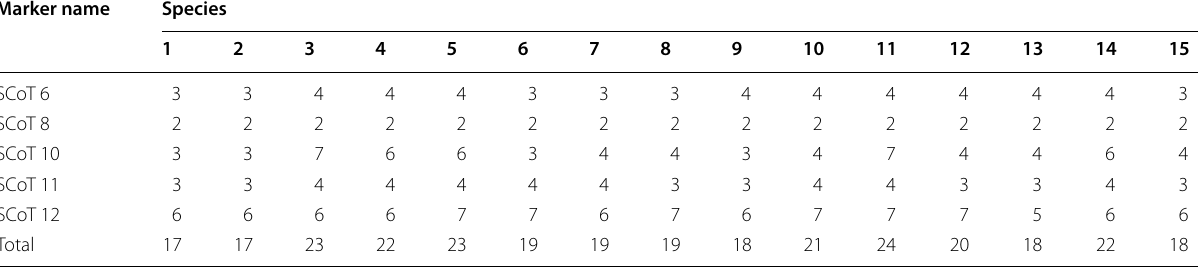
Table 2 Total bands scored by SCoT